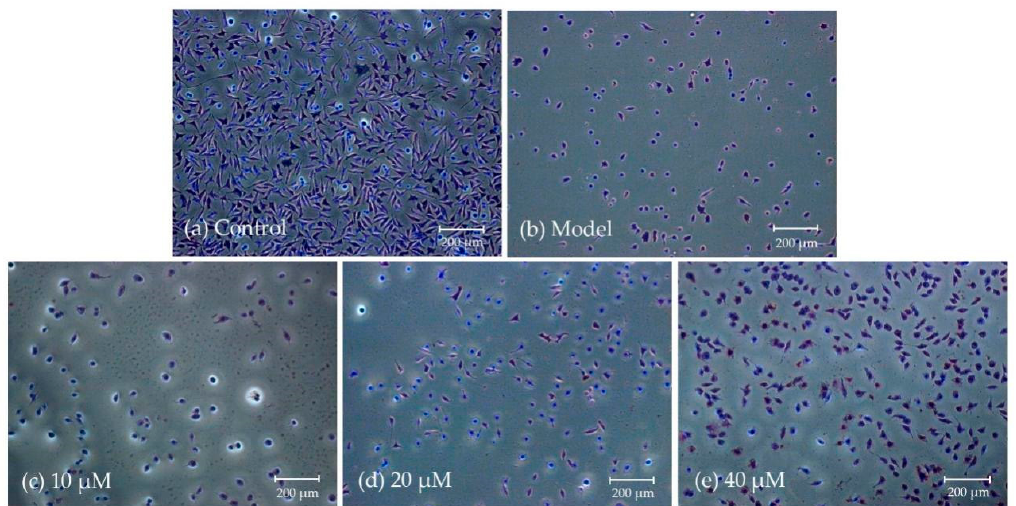
Figure 2. Giemsa staining on SH-SY5Y cells treated with compound DG-15 with different concentrations: ( a ) Control group; ( b ) TBHP treated cells; ( c ) 10 μ M; ( d ) 20 μ M; ( e ) 40 μ M. The cell morphology was observed under the fluorescence microscope. The most representative fields were shown. Calibration bar: 200 μ m.